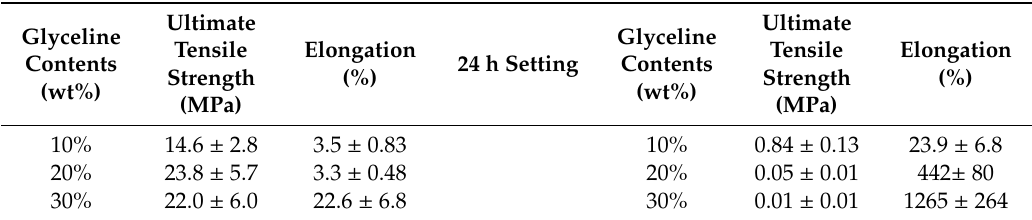
Table 3. Tensile strength and elongation for gelatin samples with di ff erent DES composites with 0.5 h and 24 h setting times (30 min